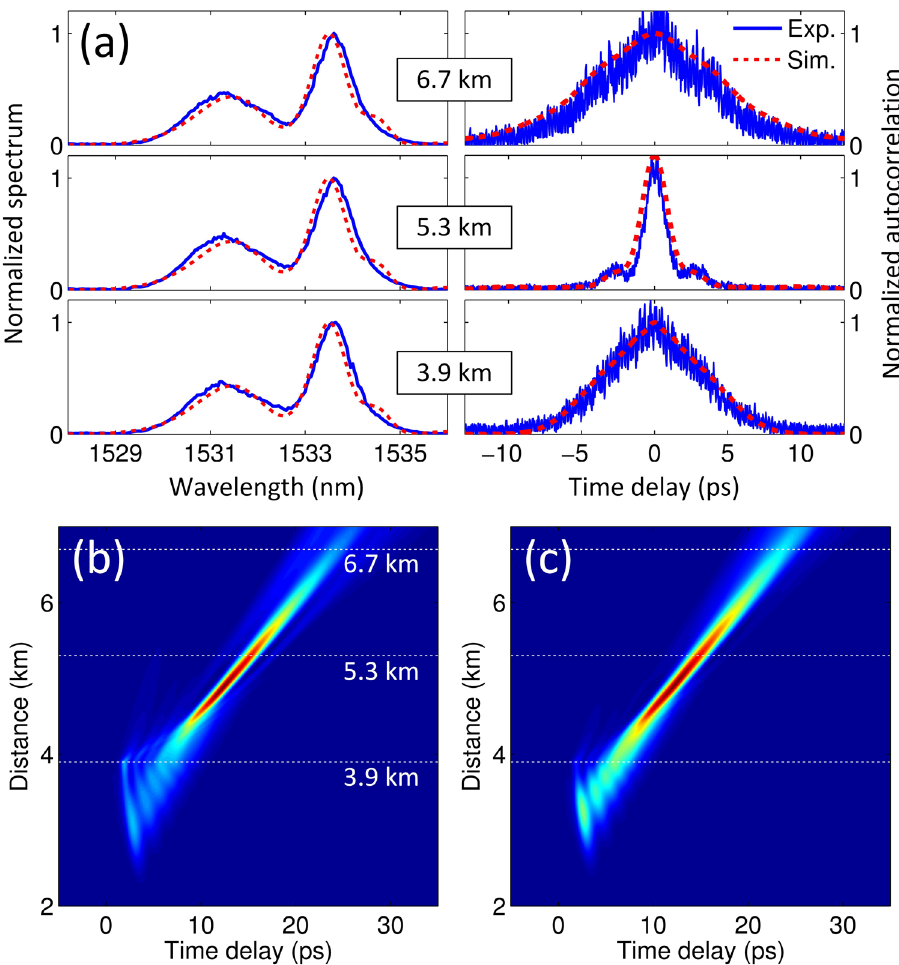
Figure 4. Observation and the associated simulations of DW shaping by employing a self-accelerating pulse. ( a ) Measured spectrum (left column) and autocorrelation intensity (right column) of the generated DWs at the output for different lengths of DSF. ( b ) Simulated DW evolution obtained by solving equation (1) with the parameters fitting the experimental data. ( c ) Same as ( b ) using a generalized model which includes the additional effects of Raman scattering, self-steepening and attenuation. We note the marginal difference in the DW dynamics following the inclusion of higher order parameters (see Supplementary Information). The white dashed lines in ( b ) and ( c ) mark the three fiber output lengths used in ( a ) for the comparison between our experiments and the related simulations based on the